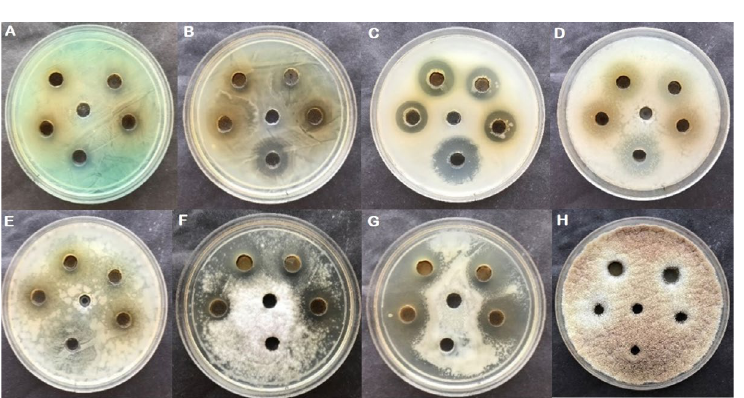
Fig. 3. Inhibition zone against bacterial and fungal pathogen in 15mg/ml concentration of Cetrelia braunsiana. A) Pseudomonas aeruginosa B) Agrobacterium tumefaciens C) Escherichia coli D) Staphylococcus aureus E)